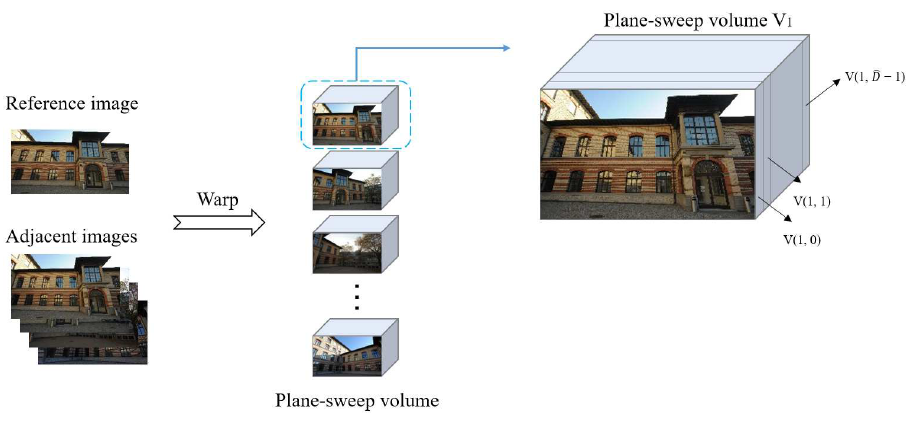
Figure 2. The plane-sweep volume